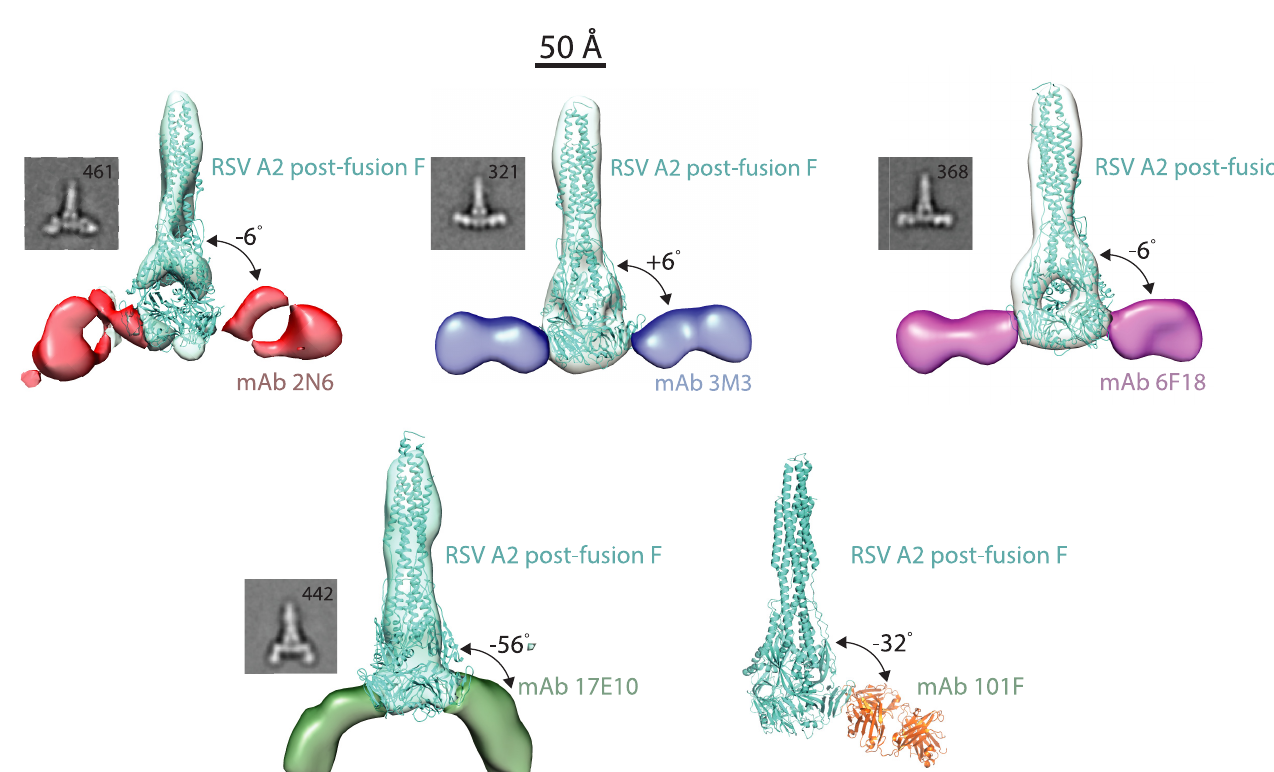
Fig 4. Multiple binding modes at antigenic site IV. Each site IV mAb was complexed with RSV A2 post-fusion F, and negative-strain electron microscopy images were generated using random-conical tilt analysis. MAbs 3M3 and 6F18 share a similar binding mode, while mAb 2N6 binds antigenic site IV at an angle allowing bypass of the Arg429 residue. MAb 17E10 binds to RSV F at an angle 42˚ from the plane of the other site IV mAbs. This unique binding pose likely mediates cross- reactivity with hMPV. 3-D reconstructions are displayed for each mAb-RSV F complex, and 2D class averages are displayed below the reconstructions. The X-ray crystal structure of the 101F-peptide complex (PDB ID: 3O41) was aligned to the antigenic site IV region on the post-fusion RSV F crystal structure